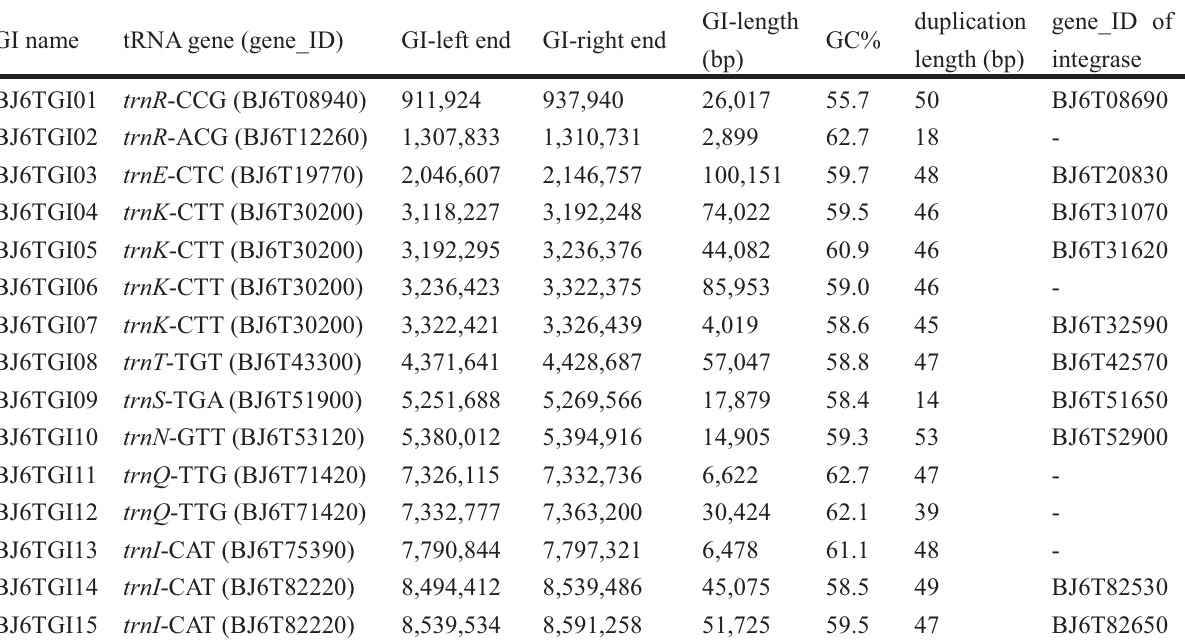
Table 5. List of genomic islands of USDA6 T